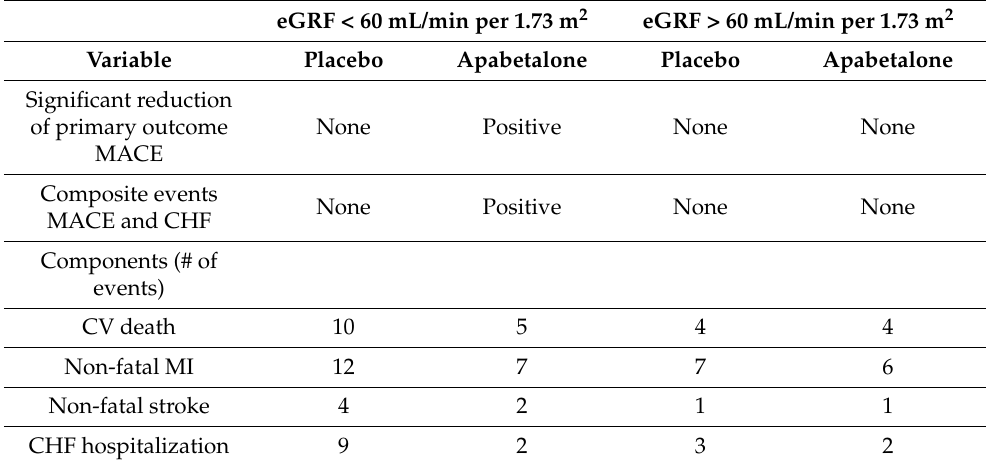
Table 2. Specific epigenetic modifications in T2D